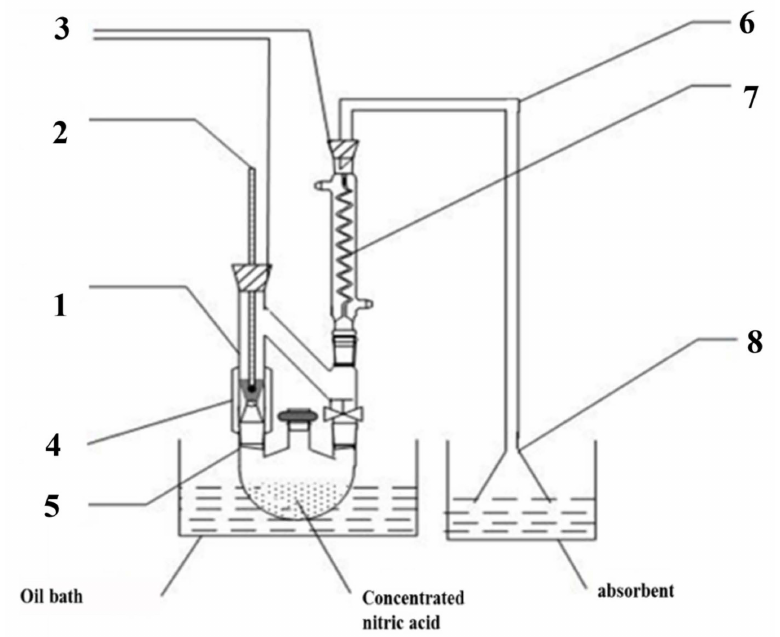
Figure 1. Self-made HNO 3 vapor treatment device ((1): steam treatment device, (2): thermometer, (3): rubber plug, (4): heating belt, (5): three-mouth flask, (6): catheter, (7): snake condensation tube, (8):